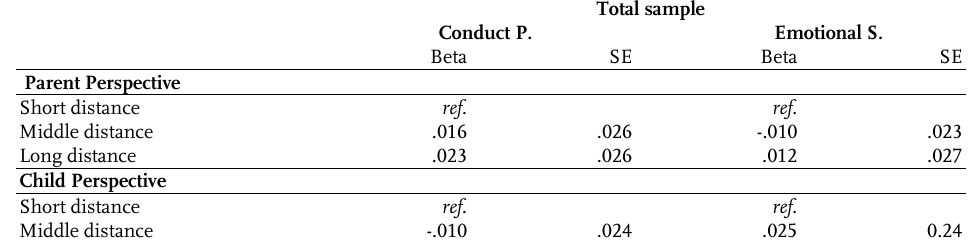
Child Perspective